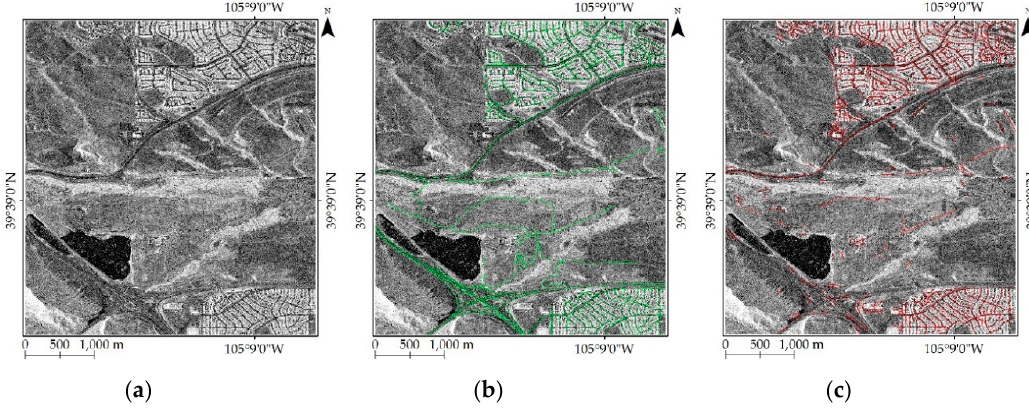
Figure 9. Road extraction results for study site 3. ( a ) Original SAR intensity image; ( b ) reference road network; ( c ) extracted road network with proposed method. Table 3. Quantitative indexes of the extracted results in test sites with di ff erent segmentation methods.